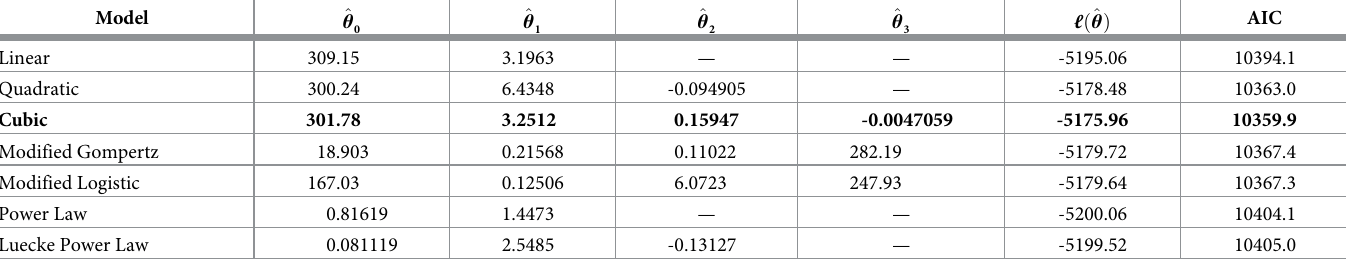
Table 14. Maternal cardiac output models (flow rate in L/h vs. maternal mass in kg for power law models, flow rate in L/h vs. gestational age in weeks for all other